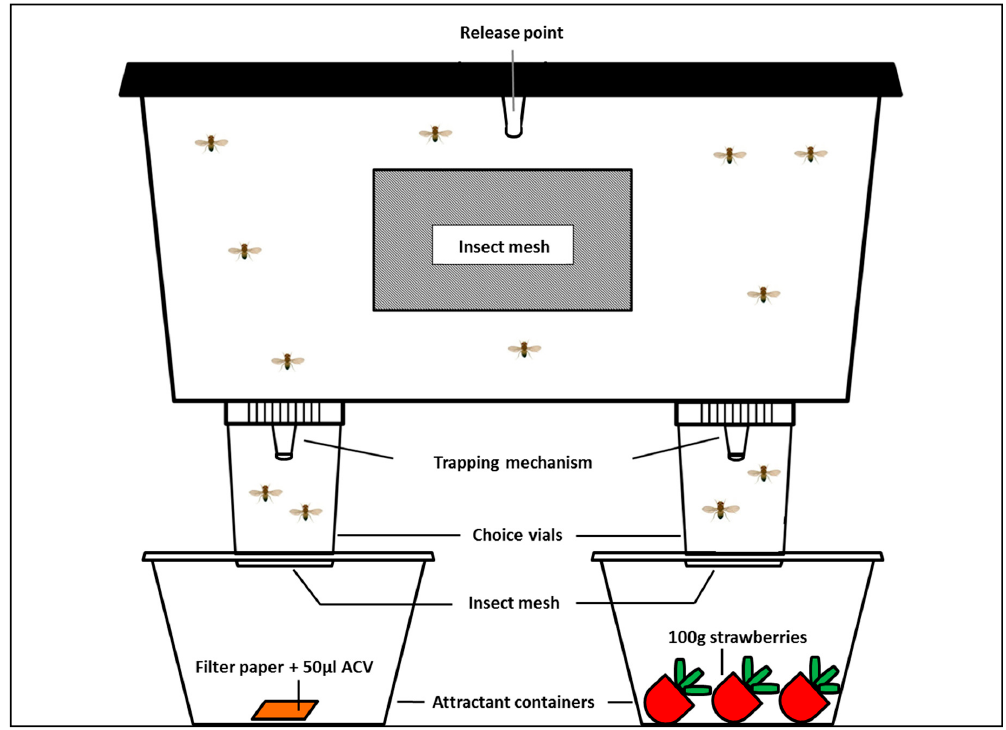
Figure 1. Side-view of the four-arm olfactometer. A fixed number of D. suzukii flies are released in the middle of the box. The trapping mechanism prevents escape once a fly has chosen. Contact with the attractant is prevented by insect mesh between the choice vials and the attractant